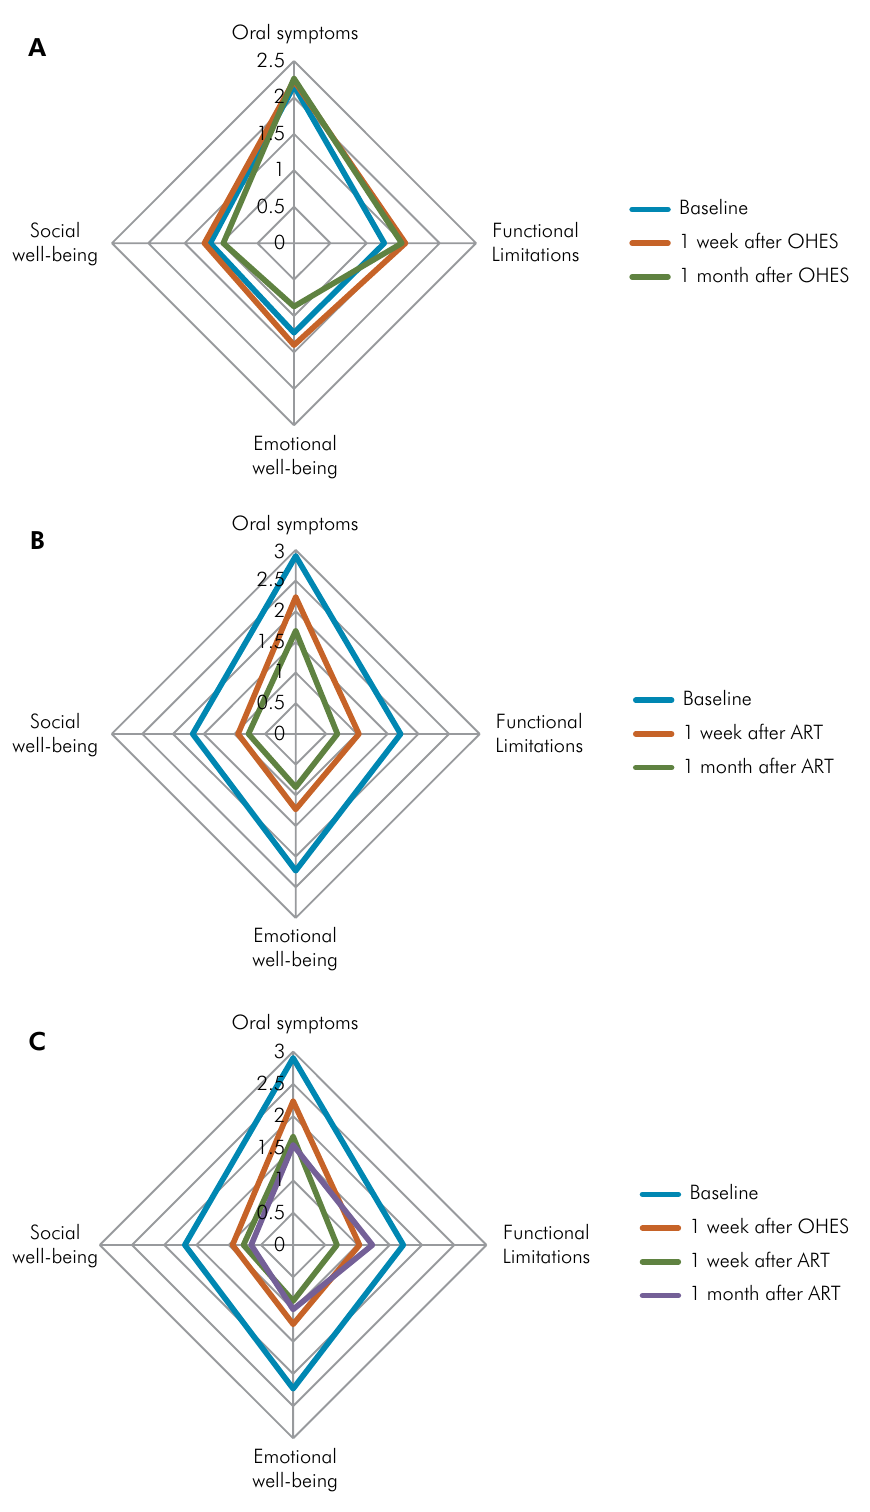
Figure 2. A. Radar chart describing the CPQ8-10-ISF:16 scores reached by the OHES group on each time point. B. Radar chart describing the CPQ8-10-ISF:16 scores reached by the ART group on each time point. C. Radar chart describing the CPQ8-10-ISF:16 scores reached by the OHES+ART group on each time